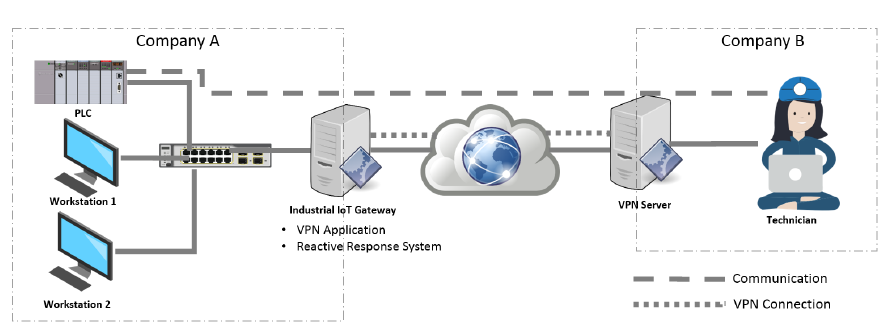
Figure 5. Simplified Industrial Scenario of a Remote Maintenance Application derived from the reference IAS architecture (Figure